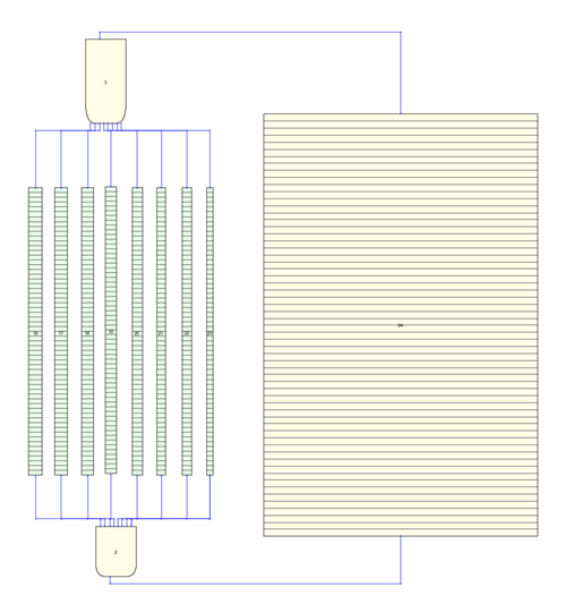
Figure 2. RELAP5 model with green pipes connected to heatstructures, bottom and top plenum, and a large pipe serving as a reactor vessel.